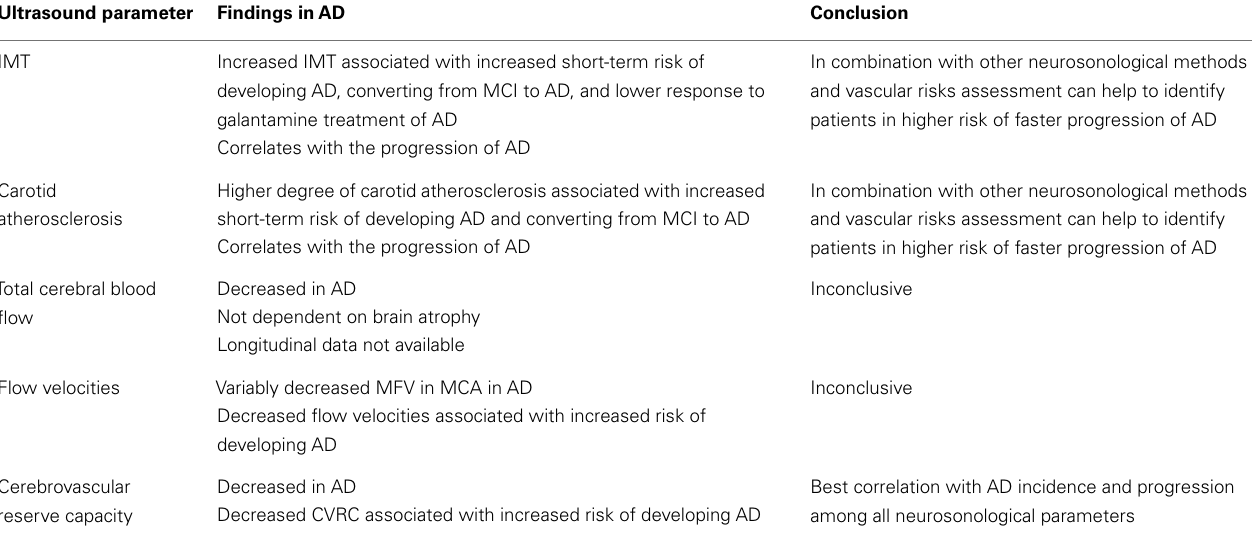
Table 5 | Neurosonological parameters inAD –